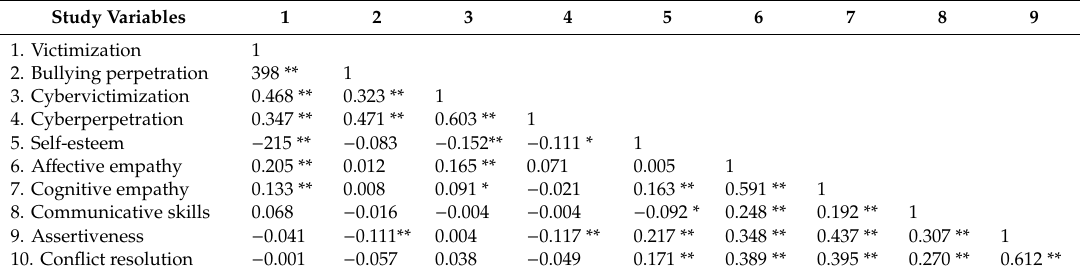
Table 2. Correlations among the study variables.